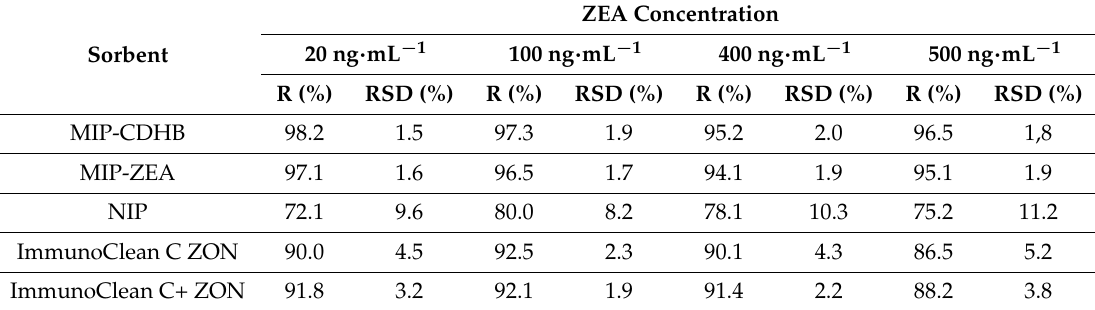
Table 7. Effectiveness of zearalenone extraction from contaminated urine at four concentration levels when MISPE and immunoassay columns are used. Recoveries (R) and relative standard deviation (RSD) calculated from six replicates.